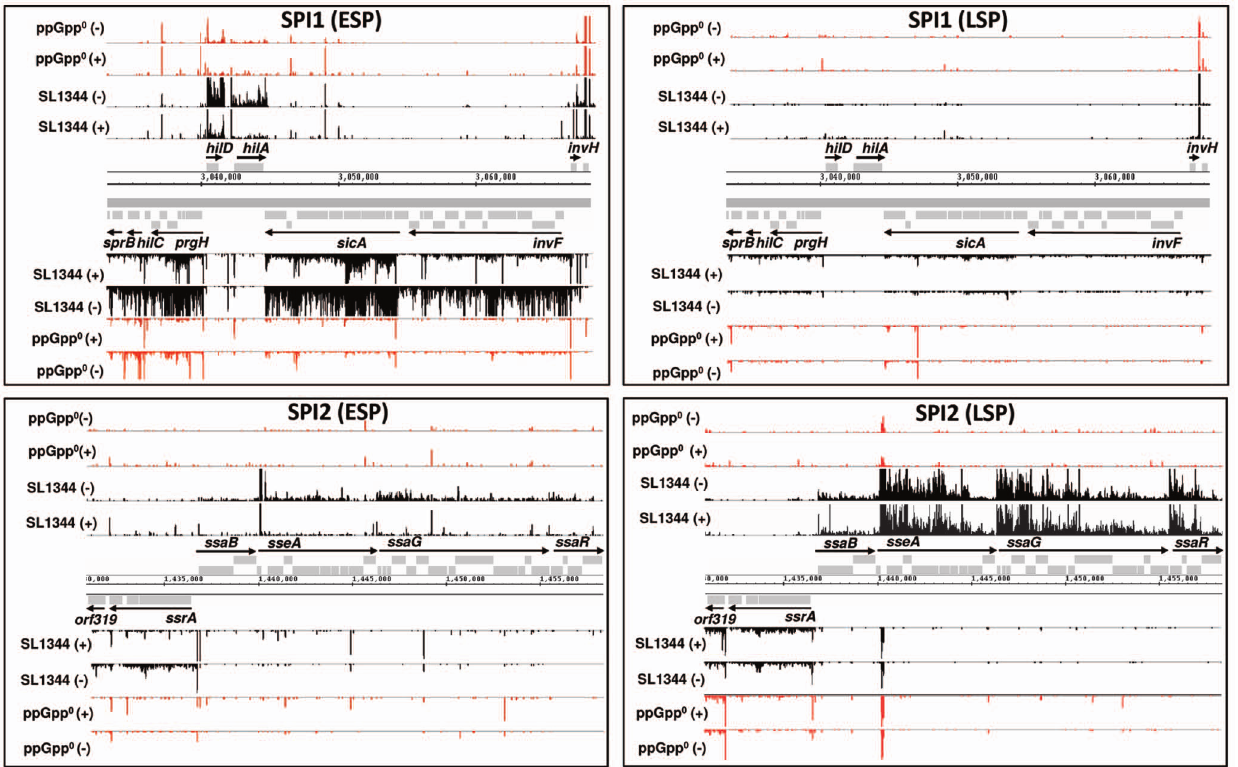
Figure 2. Transcriptional architecture of the entire SPI1 and SPI2 loci at ESP and LSP in parental and D relA D spoT strains. Enriched ( + ) and non-enriched ( 2 ) cDNAs of S . Typhimurium parental (black) or ppGpp 0 ( D relA D spoT ) (red) strains mapped onto the SPI1 and SPI2 loci. Operons are indicated by horizontal arrows and annotated according to the first gene. The Y axis in each lane represents 0–50 mapped reads per genome position. The dRNA-seq data for ESP was from [19].